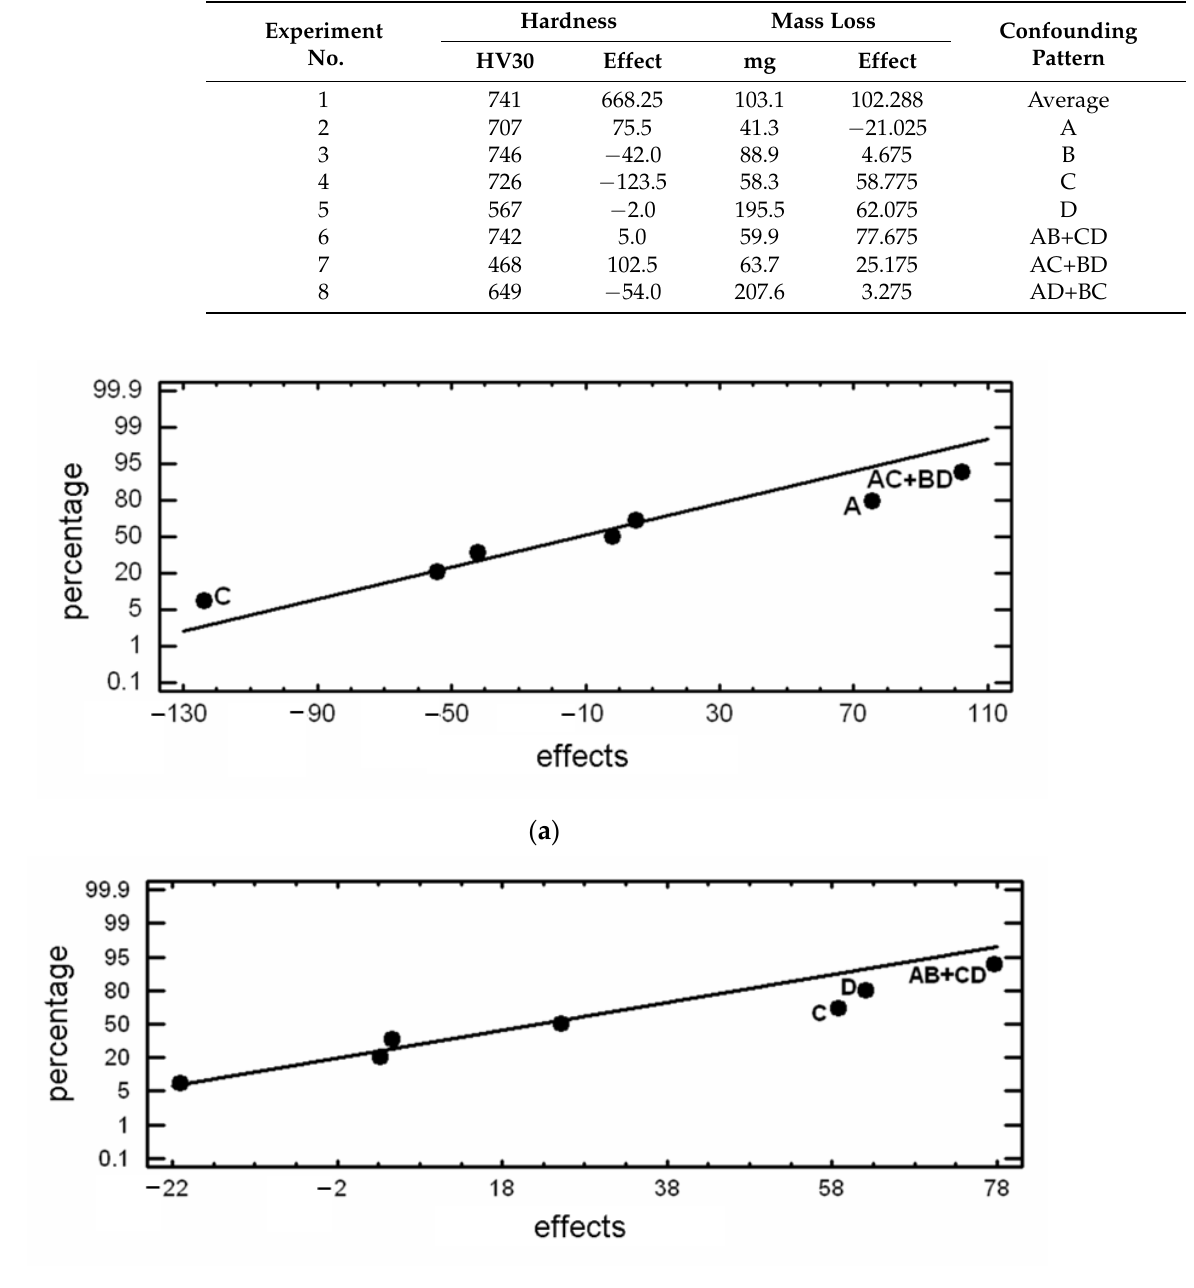
Table 5. Average values and effects obtained for Vickers hardness and for the loss of material in a reciprocating sliding wear test against a WC-Co ball.